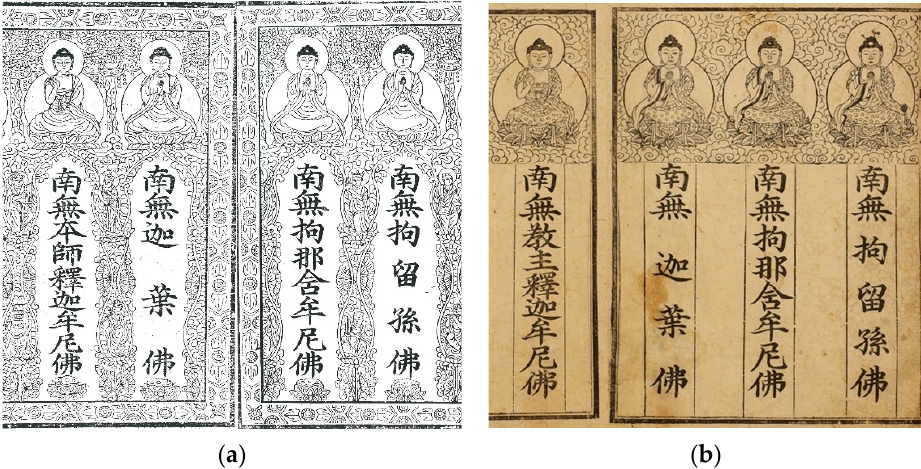
Figure 8. The Buddha iconography from ( a ) Sanggyojeong Edition of Repentance Rituals of Compassion Altar ; ( b ) Contrition in the Name of Amitabha Buddha (Arranged by the author).